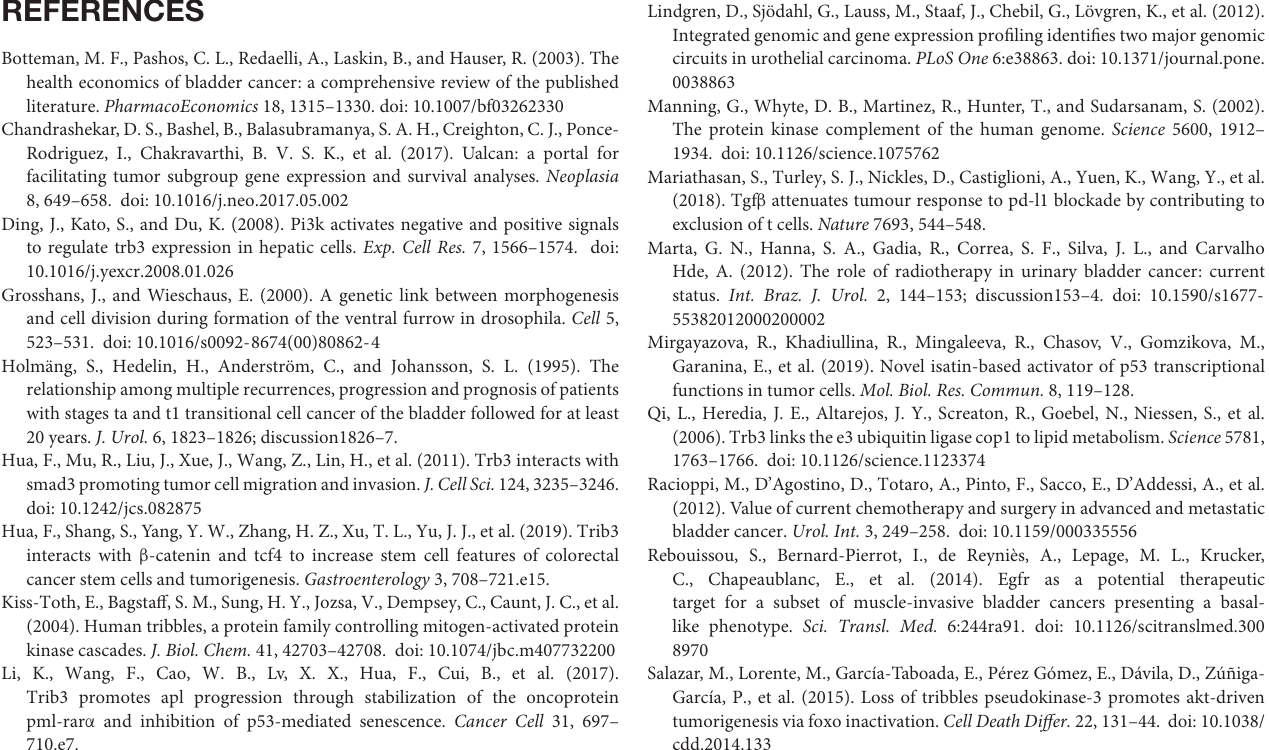
Supplementary Table 1 | C-index of the TRIB3, T stage and Integrative